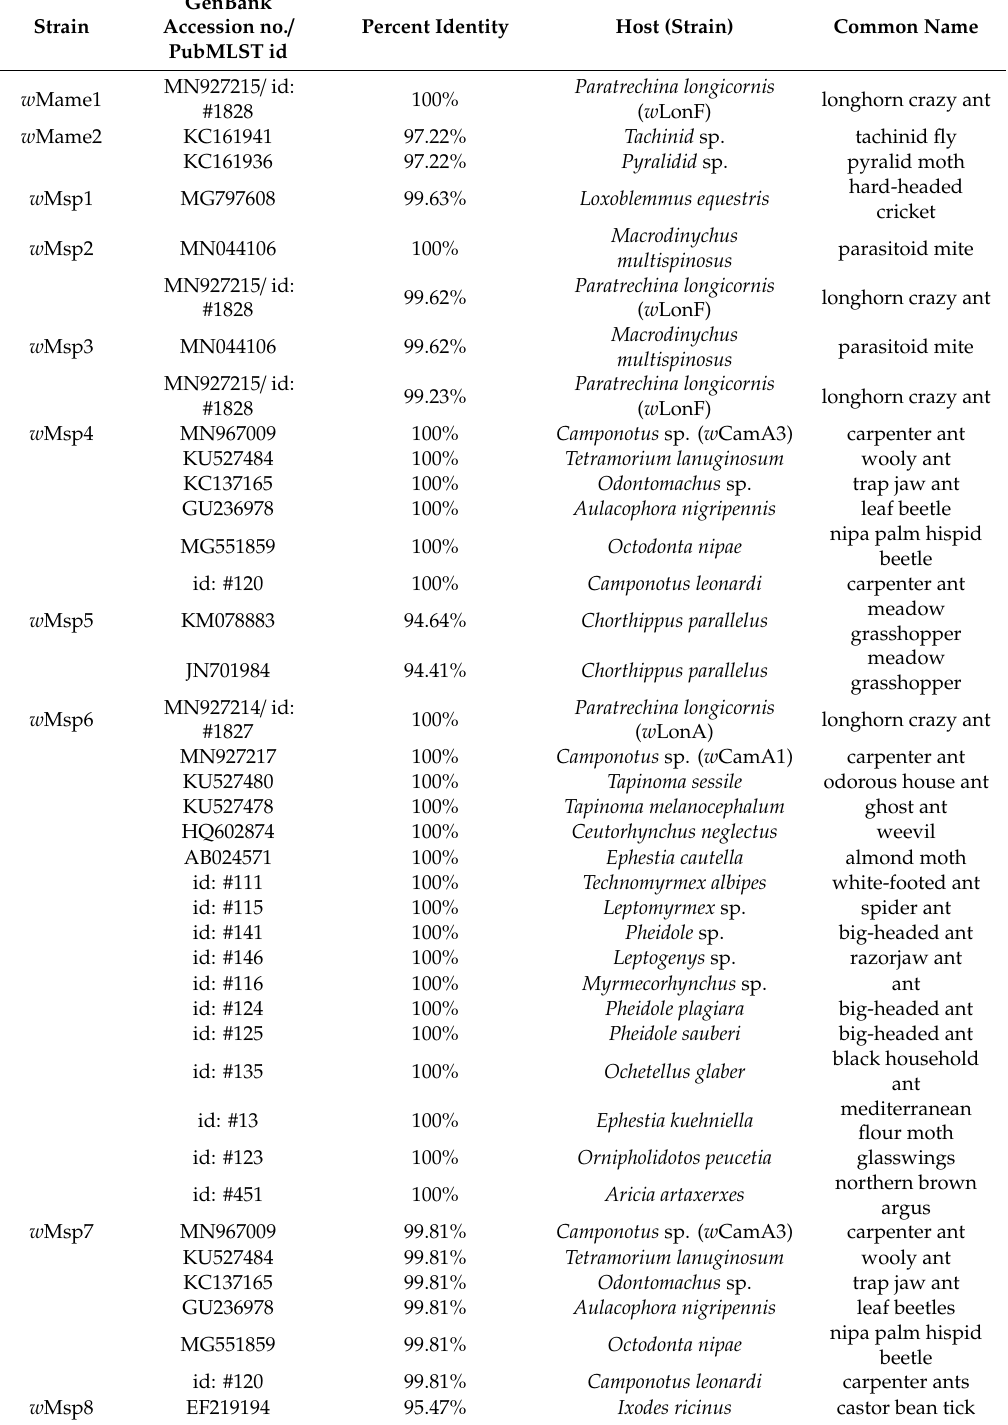
Table 2. Comparisons of wsp sequences of Wolbachia from tested ant crickets and those in the GenBank and PubMLST